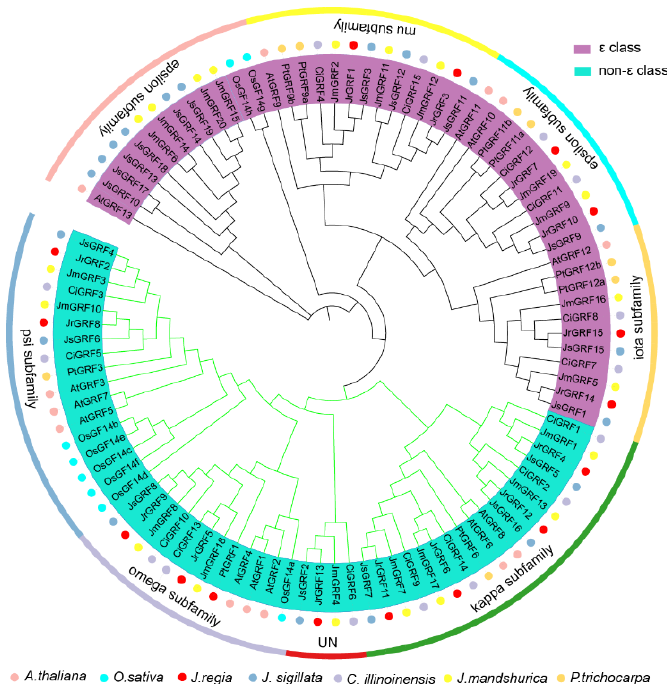
Figure 1. Phylogenetic tree of the GRF gene family in the four Juglandaceae species ( J. regia , C. illinoinensis , J. sigillata , and J. mandshurica ) and O. sativa , P. trichocarpa , and A. thaliana .